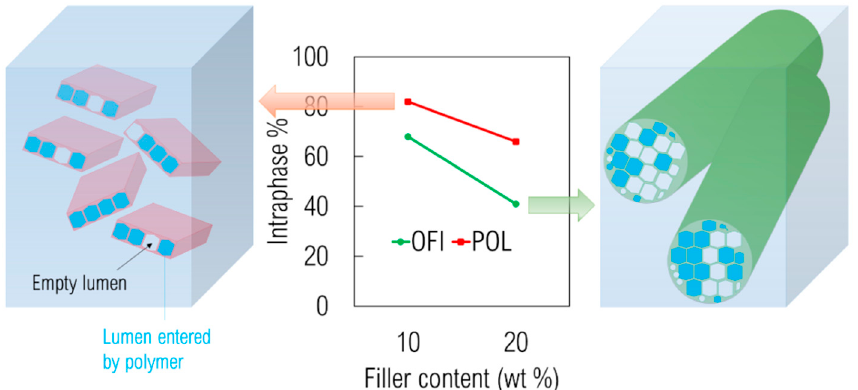
Figure 9. Intraphase plotted as a function of filler content for systems containing OFI and POL, together with pictorial representations of empty and filled lumens in POL10 ( left ) and OFI20 ( right ).